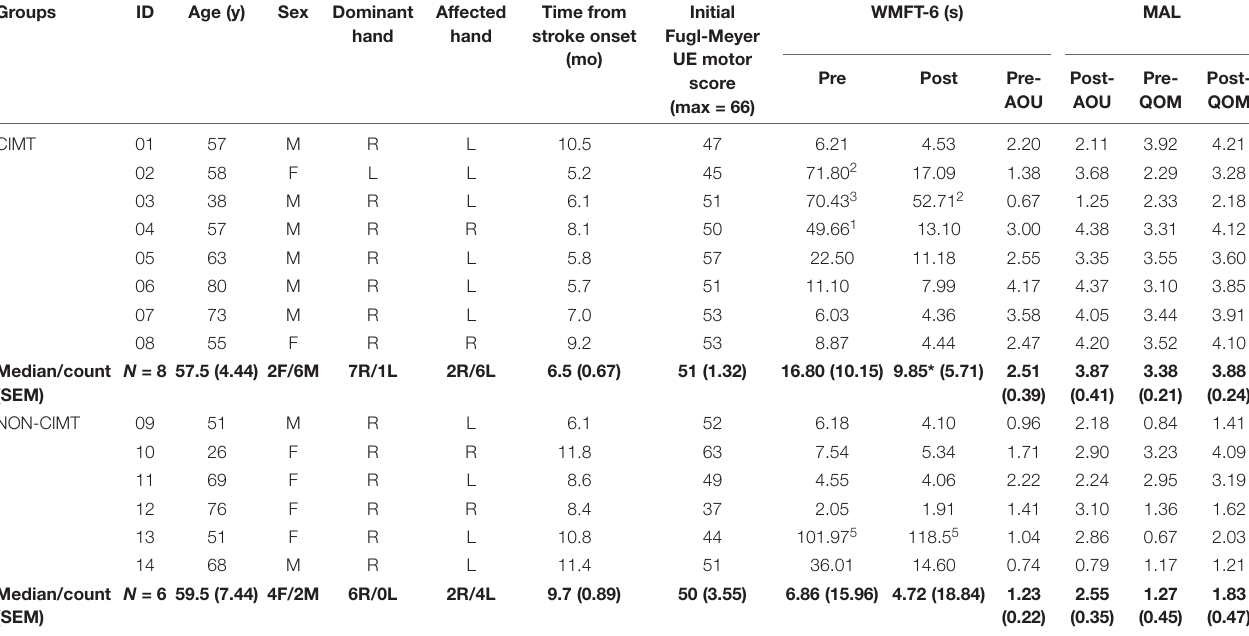
TABLE 1 | Characteristics of the constraint-induced movement therapy (CIMT) group and non-CIMT group and effect of CIMT treatment on behavioral outcomes